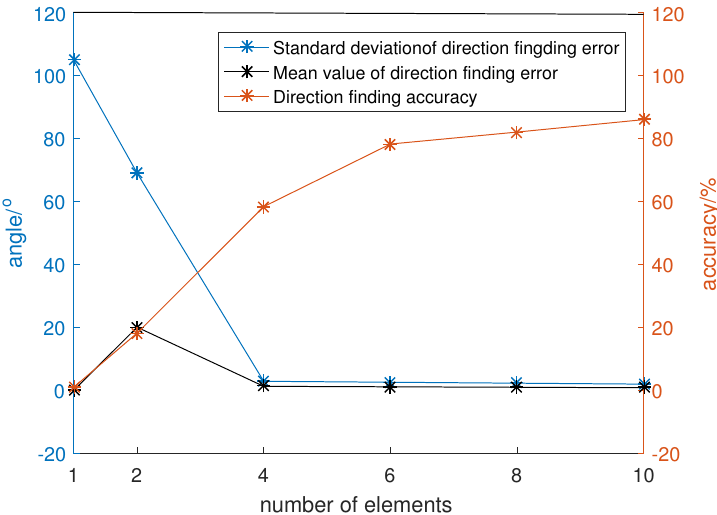
Figure 7. Direction-finding performance under different array elements.